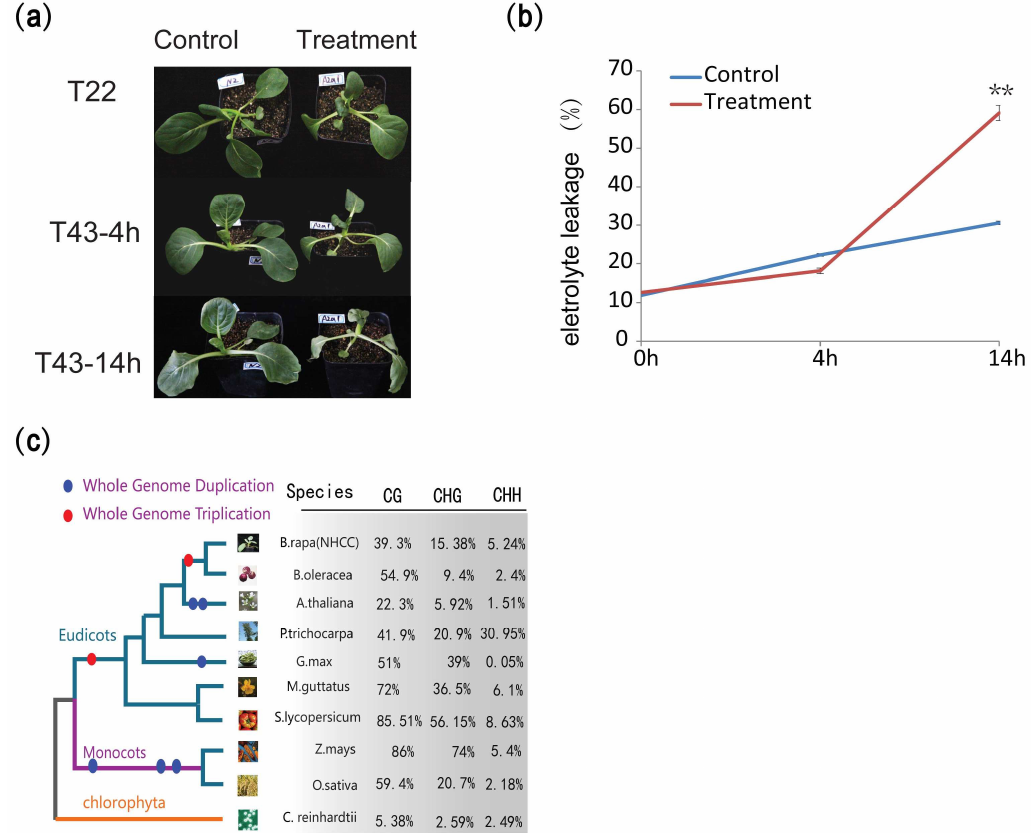
Figure 1. Application of a methylation inhibitor decreases the heat stress tolerance of NHCC001 and the DNA methylation landscape of non-heading Chinese cabbage. ( a ) Five-leaf stage seedlings were treated at 43 °C for 4 and 14 h. The treatment groups were pretreated with 5-azacytidine, a general inhibitor of DNA (cytosine-5) methyltransferases. Seedlings treated with 5-azacytidine (100 μmol; right, treatment) showed decreased heat tolerance, compared to the untreated seeding (left, control). ( b ) The relative electrolyte leakage was determined for the seedlings treated at 43 °C for 0, 4 and 14 h (** denotes p -value < 0.01, t -test). ( c ) Overall methylation levels in B. rapa and the other nine species previously